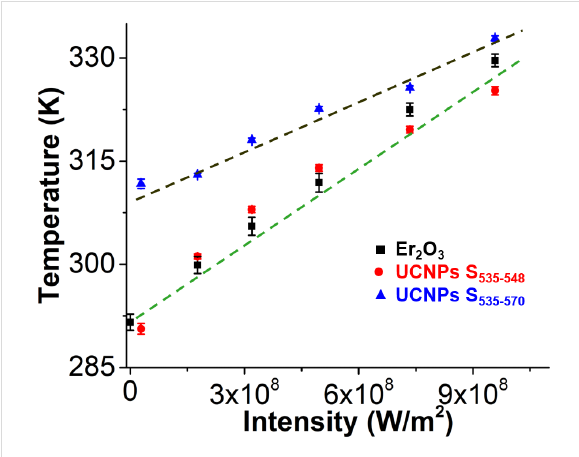
Figure 4: A plot of the temperature of water calculated as a function of the 980 nm laser intensity using two different nanothermometers, namely erbium oxide (Er 2 O 3 ) and UCNPs. The temperature of UCNPs is calculated using both the full S-band from 535 to 570 nm and the partial S-band from 535 to 548 nm. The temperature calculated using S 535–548 is in good agreement with our reference thermal sensor using Er 2 O 3 nanoparticles